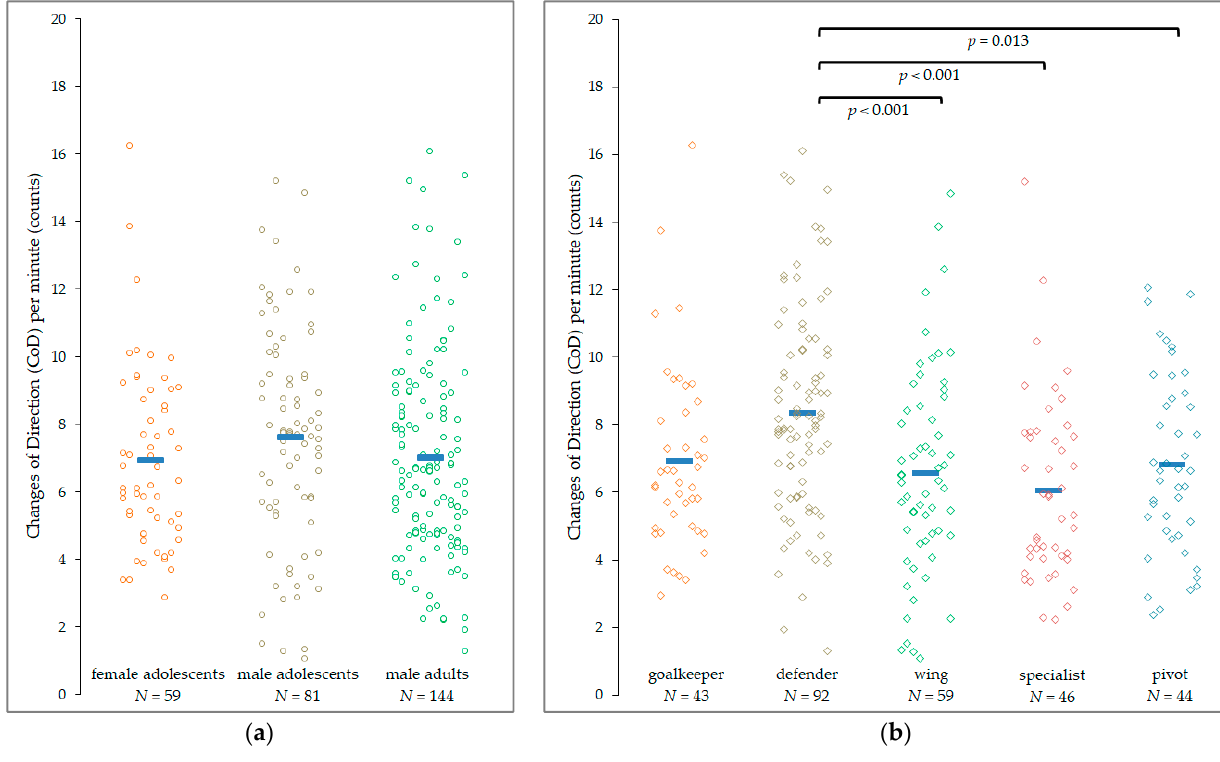
Figure 2. Number of changes in direction (counts/minute) across the subgroups: ( a ) subgroup 1 (age/sex); ( b ) subgroup 2 (playing position).